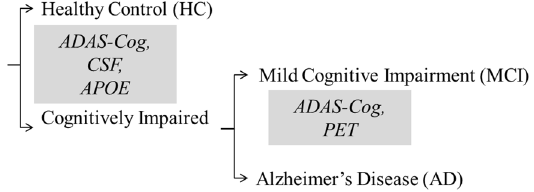
Figure 1. The cascade and the modalities for fusion at each level of the cascade were determined on training set and validated on independent testing set. Neurophysiological test scores (ADAS-Cog) are fused with CSF proteomics and APOE at the first level of the cascade to identify healthy controls (HC). At the second level, ADAS-Cog scores are combined with PET to distinguish between patients with Alzheimer’s Disease (AD) and mild cognitive impairment